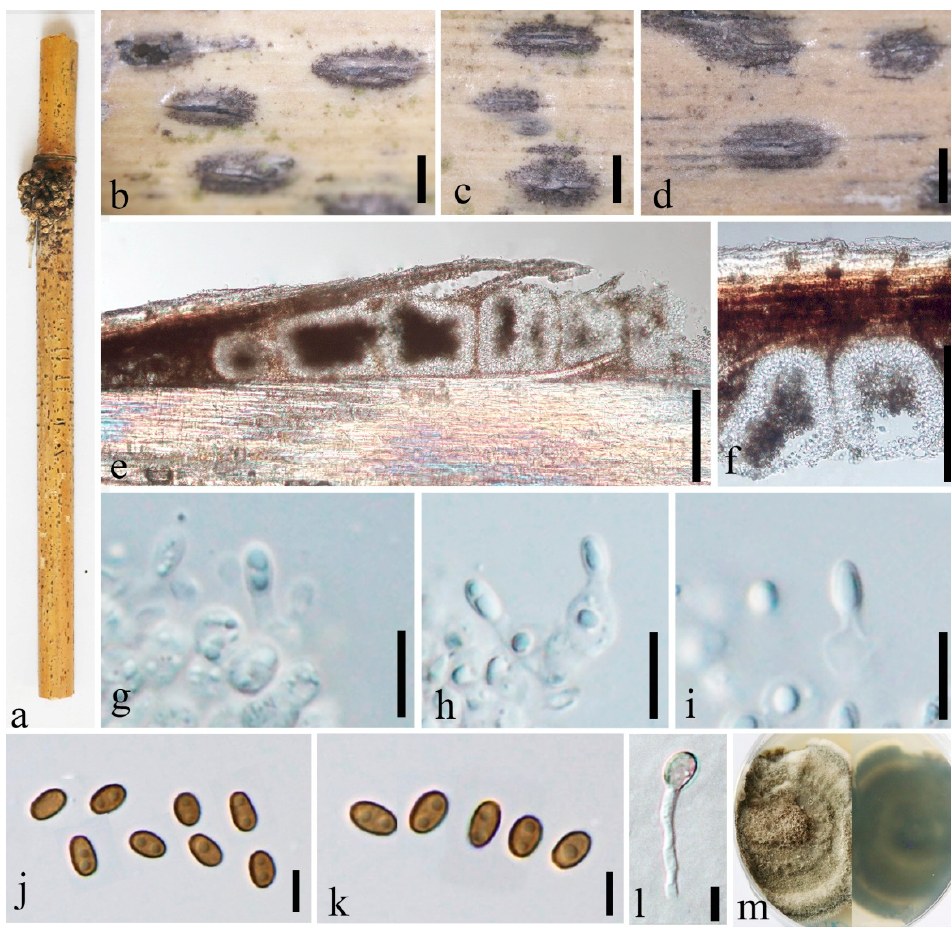
Figure 5. Roussoella multiloculate (GMB1207, holotype). ( a ) Bamboo specimen; ( b – d ) black conidi- omata on host surface; ( e , f ) vertical sections of conidiomata; ( g – i ) conidia attached to conidioge- nous cells; (j, k ) conidia. ( l ) germinating conidium. ( m ) cultures on PDA from above and below. Scale bars: ( b – d ) = 500 μ m, ( e , f ) = 100 μ m, ( g – l ) = 5 μ m.